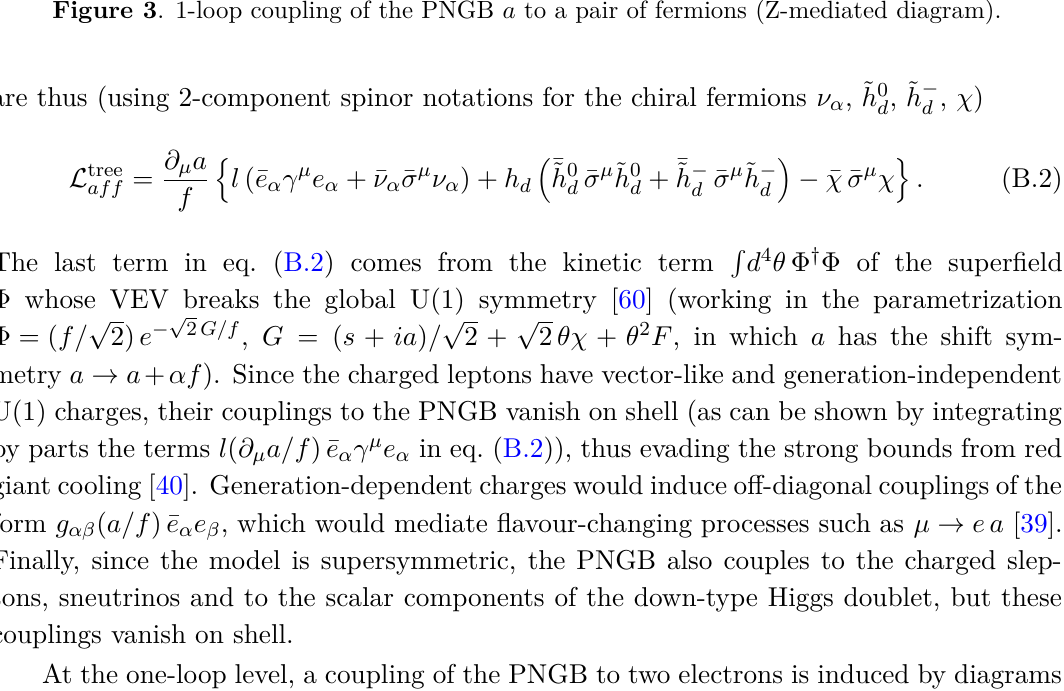
Figure 3 . 1-loop coupling of the PNGB a to a pair of fermions (Z-mediated